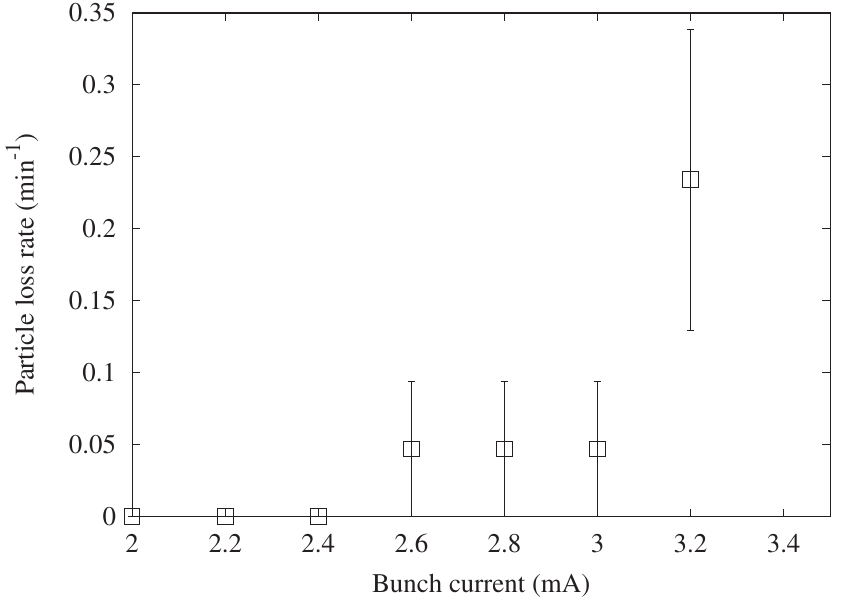
(cid:8)(cid:7) (cid:1) N=n (cid:8) . (cid:1) N (cid:1) 0 for bunch current less than 2.4 mA. The lifetime is about 20 min at 2.6 mA. In CESR =N FIG. 11. 1 =(cid:5) (cid:1) (cid:7) f mp t rev we measure a lifetime of about 40 min with an average current of 1.9 mA/bunch.